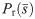
Bimodality ranges for the reduced model and effects of inhomogeneity.(A) The reduced maximum-entropy model Eq (9) yields a distribution Pr(s¯) that is either unimodal or bimodal, depending on the number of neurons N and the values of the experimental constraints (Er(s¯),ρ¯). Each curve in the plot corresponds to a particular N (see legend) and separates the values (Er(s¯),ρ¯) yielding a unimodal distribution, below the curve, from those yielding a bimodal one, above the curve. The curves are symmetric with respect to Er(s¯)=0.5 (ranges Er(s¯)>0.4 not shown). Note how the range of constraints yielding bimodality increases with N. Coloured dots show the experimental constraints from our dataset for different time-binnings with widths Δ = 1 ms, Δ = 3 ms, Δ = 5 ms, Δ = 10 ms: all these binnings yield a bimodal distribution. (B) Probability distributions of the reduced model for the population-averaged activity, Pr(s¯|N), obtained using the constraints Eq (15) from our data set (3 ms purple dot in panel A) and different N (same colour legend as panel A). (C) Population-averaged activities s¯(t) from several instances of Glauber dynamics, all with the same normally-distributed couplings Jij and biases hi, with means as in Eq (16) and Fig 4B, and standard deviations σ(Jij) = 0.009, σ(hi) = 0.8. Each instance starts with an initial population activity s(0) having different values of the population average s¯(0), and is represented by a different red shade, from Ns¯(0)=0 (light red) to Ns¯(0)=N (dark red). Note how the basins of attraction of the two metastable regimes are wider than in the homogeneous case of Fig 4B. (D) The same as panel C, but with larger standard deviations σ(Jij) = 0.012, σ(hi) = 1.08; the jumps between the two metastable regimes become more frequent than in Fig 4B, indicating that the minimum between the modes becomes shallower as the inhomogeneity increases.